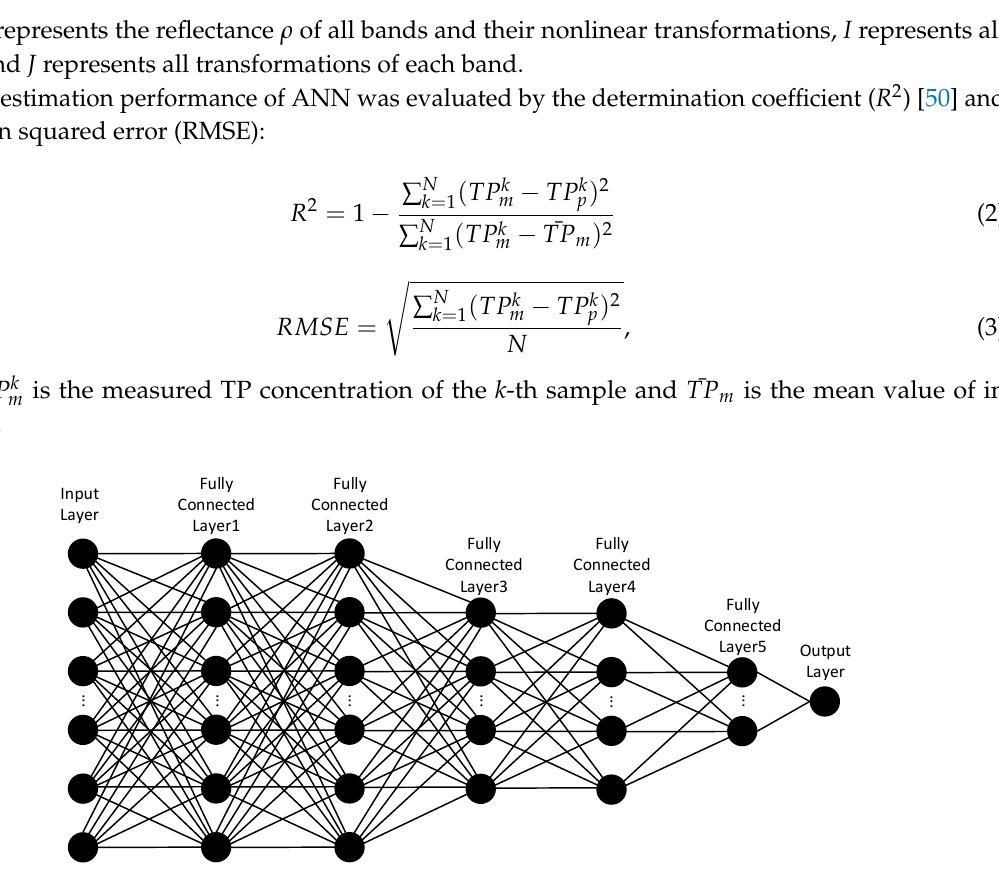
Figure 2. Structure of the artificial neural network for total phosphorus